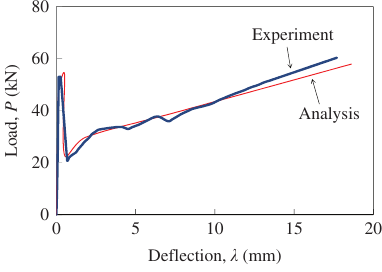
Figure 12 Comparison of experiment with analysis (Center rein- forced